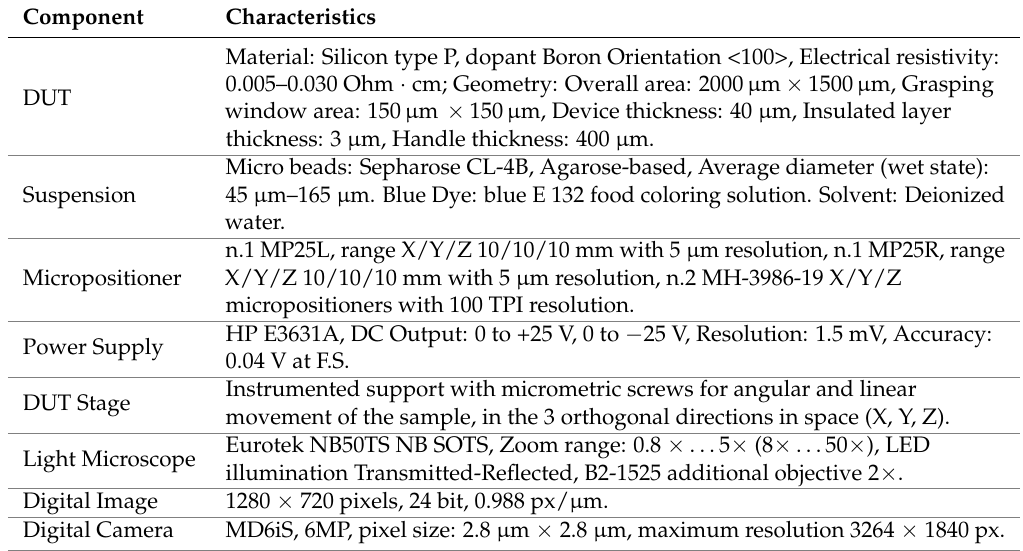
Figure 3. A detailed view of the the DUT and the probe arms: probes ( a ), wafer area with micro machined windows ( b ), operating area ( c ), DUT ( d ) and water drop ( e ). In Table 1, the overall components of the experimental setup are reported. Table 1. The components of the experimental